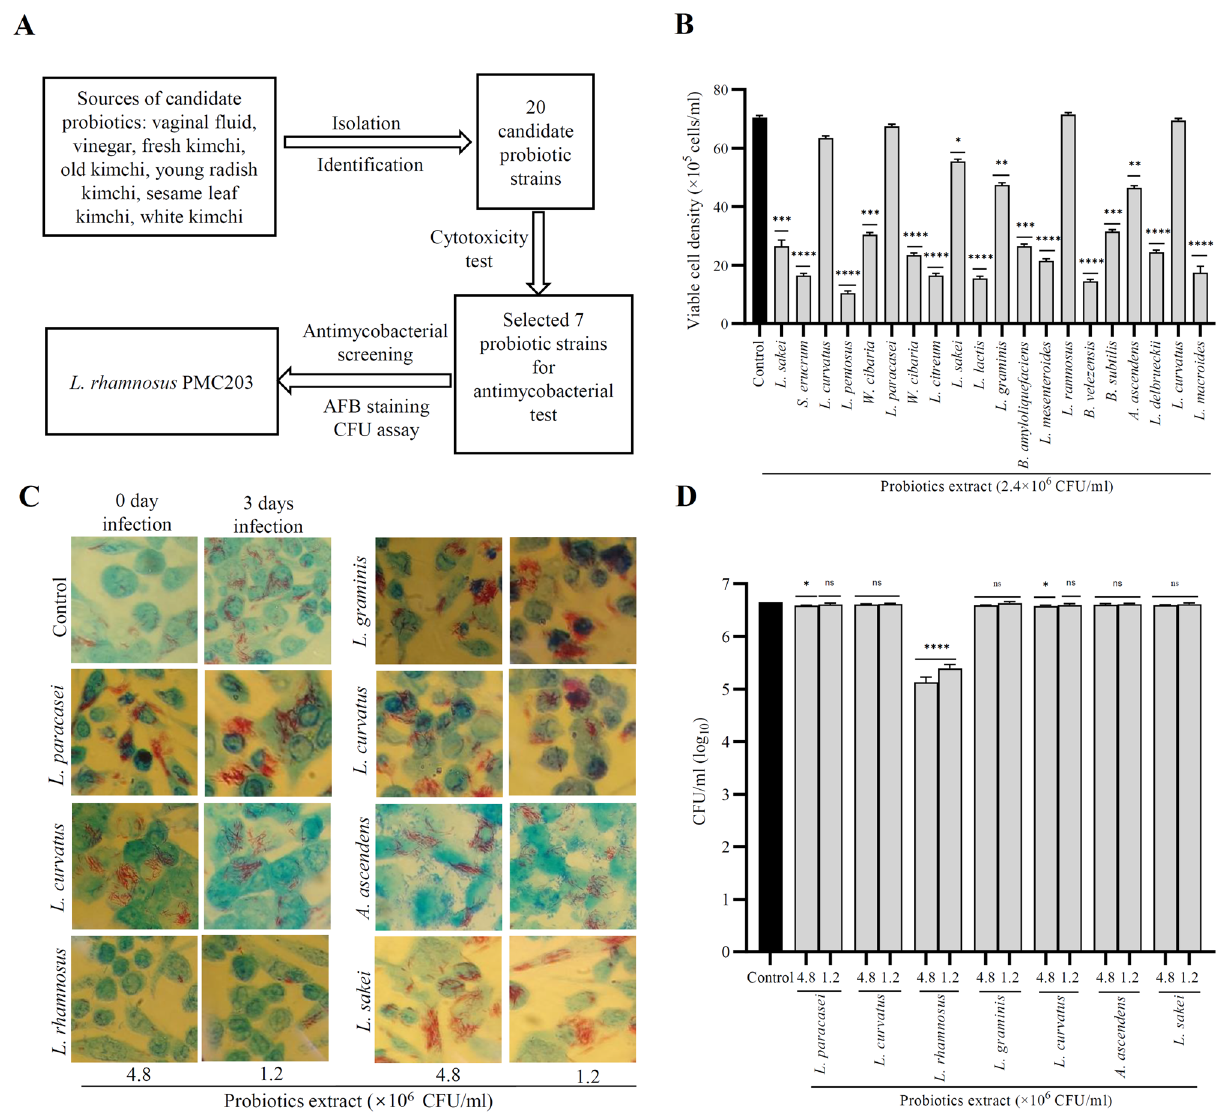
Figure 1. Anti-mycobacterial screening of candidate test probiotics. ( A ) Schematic diagram of the study. ( B ) Monolayers of macrophage cells were treated with the extract of test candidate probiotics and viability was checked using the trypan blue assay. Based on the viability, 7 probiotic strains were selected for anti- mycobacterial screening by ( C ) acid-fast bacilli staining and ( D ) CFU assay. These experiments were carried out in triplicate and statistical significance with controls was analyzed using Graph Pad Prism 9.1.1, one- way ANOVA (*p < 0.05, **p < 0.01, ***p < 0.001, ****p < 0.0001). Control images were taken at days 0 and 3 of infection, while treated cells images were taken after 3 days of incubation (left, 4.8 × 10 6 CFU/ml; right, 1.2 × 10 6